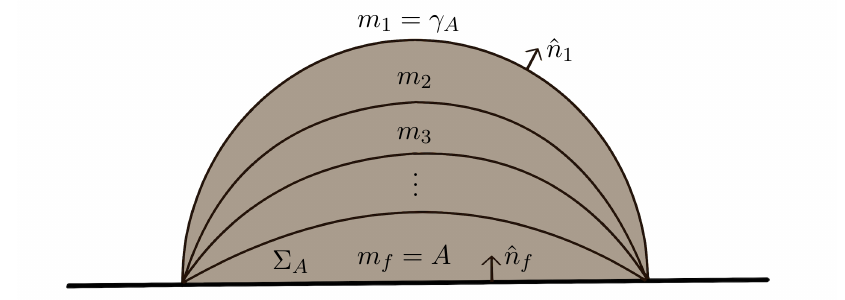
Figure 1 . Family of bulk surfaces m i homologous to the boundary region A that continuously interpolate between γ and A , and hence foliate Σ A A